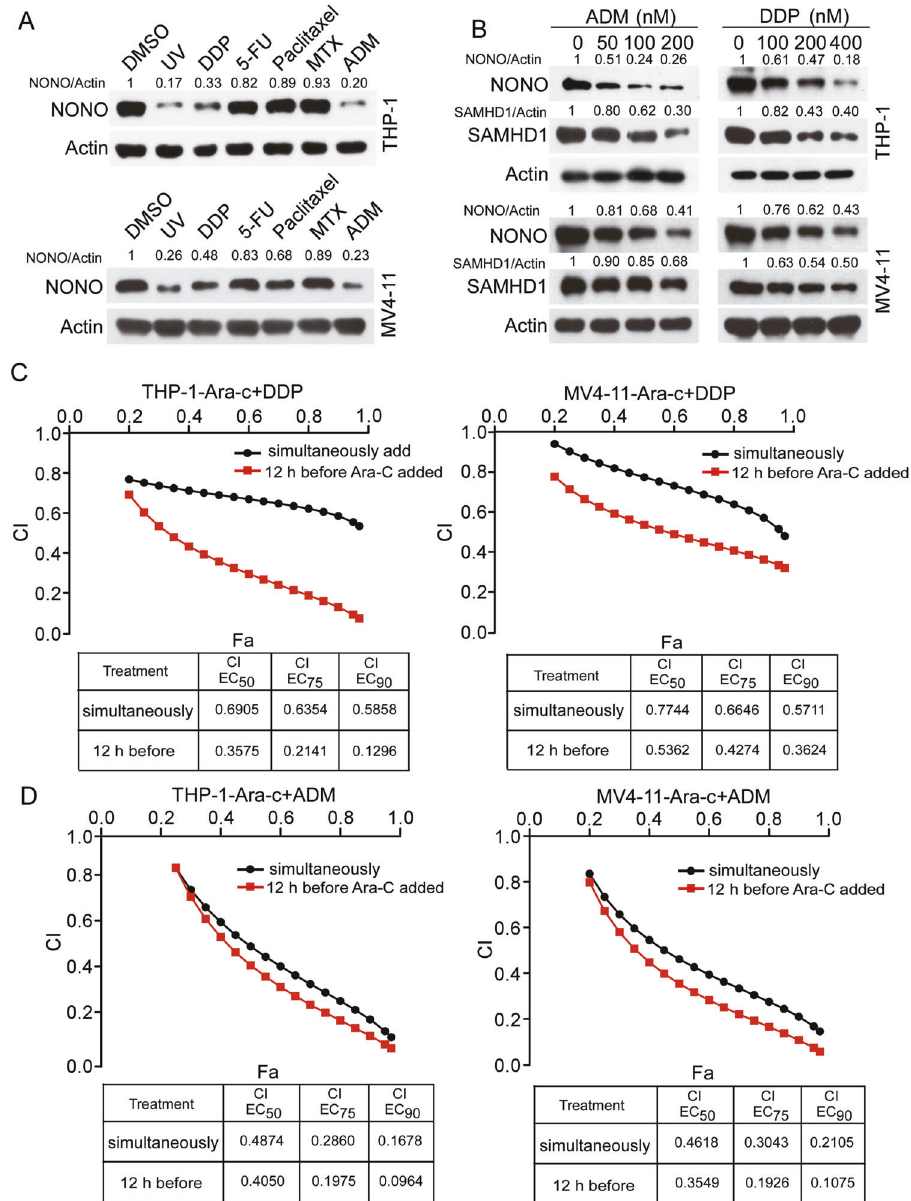
Fig. 6 DDP and ADM show synergistic effects with Ara-C in killing AML cells. A Screening of the potential chemical agents able to downregulate NONO expression. THP-1 and MV4-11 cells were treated with the indicated concentrations of drugs, including DDP (1 μ M), 5-FU (2 μ M), paclitaxel (3.5 μ M), MTX (0.1 μ M), and ADM (0.1 μ M), for 48 h or with UV radiation (30 J/m 2 ), and the levels of the indicated proteins were evaluated by western blotting. DMSO was used as the negative control. B DDP and ADM downregulated the protein expression of NONO and SAMHD1 in AML cells. THP-1 and MV4-11 cells were treated with the indicated concentrations of drugs for 48 h, and the levels of the indicated proteins were evaluated by western blotting. C , D DDP and ADM sensitized AML cells to Ara-C. Plots of the CIs for Ara-C and DDP ( C ) or ADM ( D ) in THP-1 and MV4-11 cells, as determined using the Chou – Talalay method ( n = 3). Red lines: AML cells were treated with DDP or ADM for 12 h and then added with a series concentration of Ara-C for 36 h. Black lines: Ara-C and DDP or ADM were added simultaneously into AML cells and then incubated for 48 h. For respective immunoblots, the protein levels were quanti fi ed by ImageJ